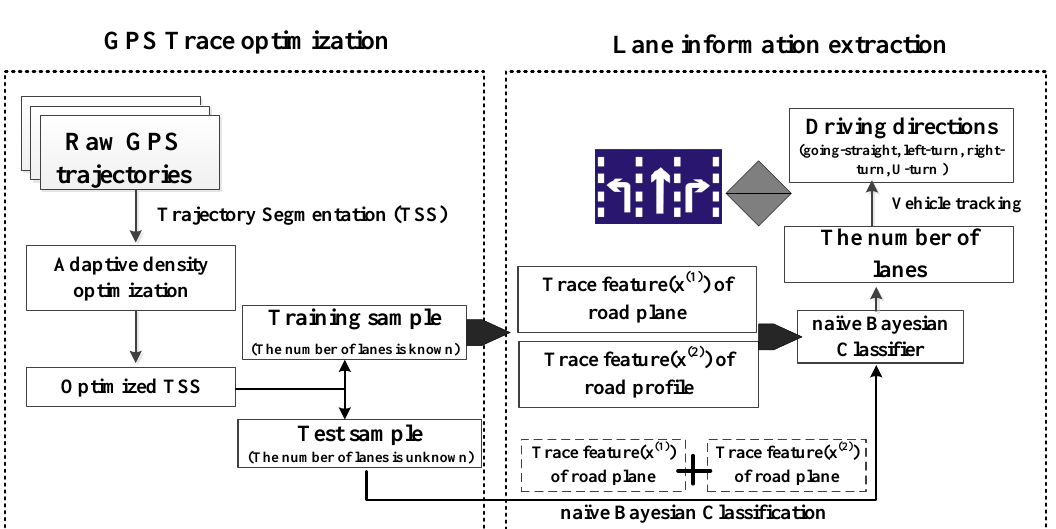
Figure 1. Lane information extraction architecture.